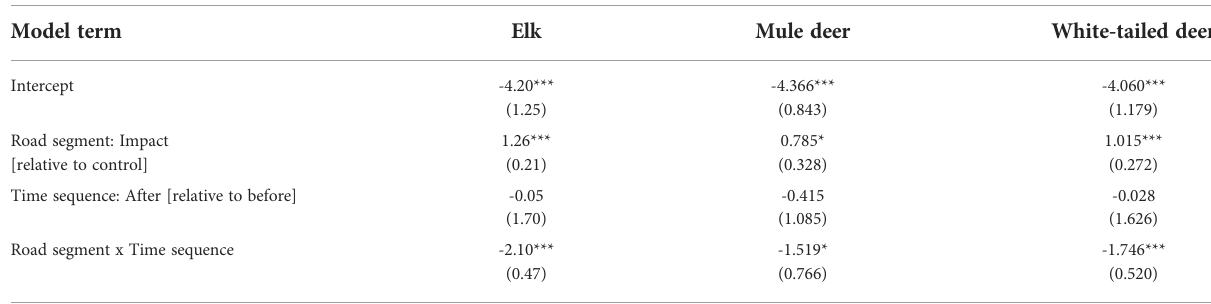
TABLE 2 Summary of the mixed-effect Poisson models to test for the interaction between road segments (control vs. impact) and time sequence (before vs. after) on elk, mule deer, and white-tailed deer. Species Model term Elk Mule deer